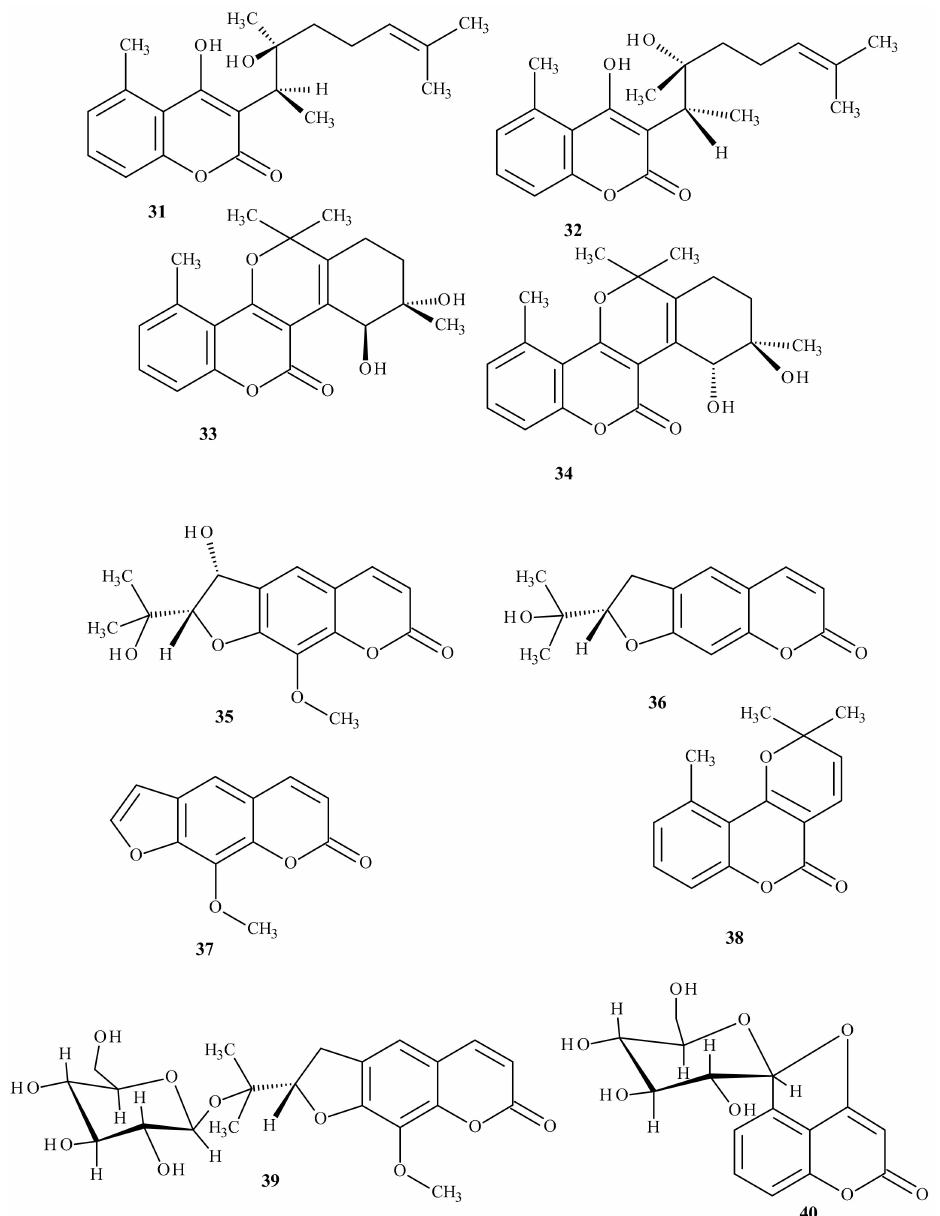
Figure 13. Coumarin related compounds isolated from Ainsliaea